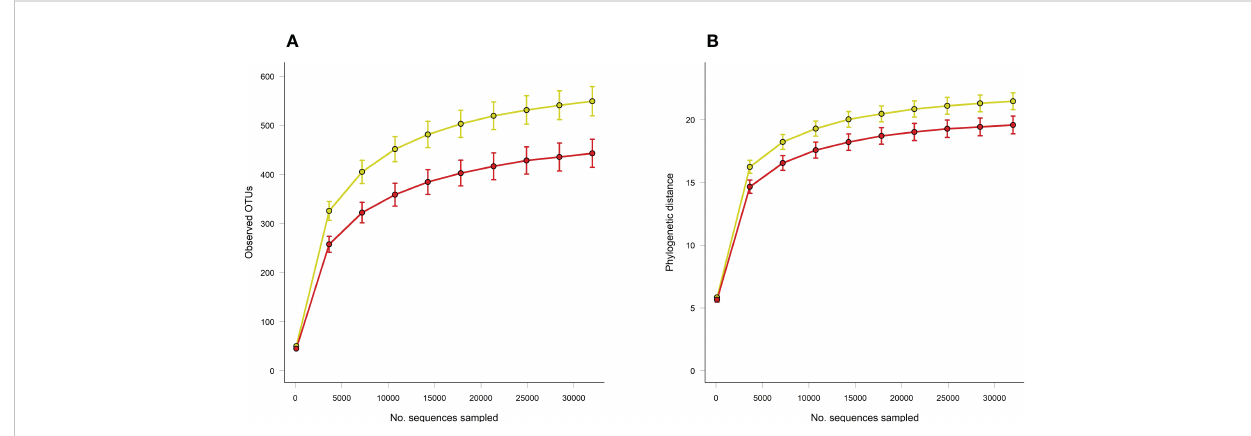
FIGURE 3 Rarefaction curves of (A) observed OTUs and (B) Faith ’ s phylogenetic distance (PD) between caecal microbiotas from control (yellow) or loperamide-treated (red) groups. Error bars show SEM of 10 iterations per sampling depth. Observed OTUs P=0.017, Faith ’ s PD